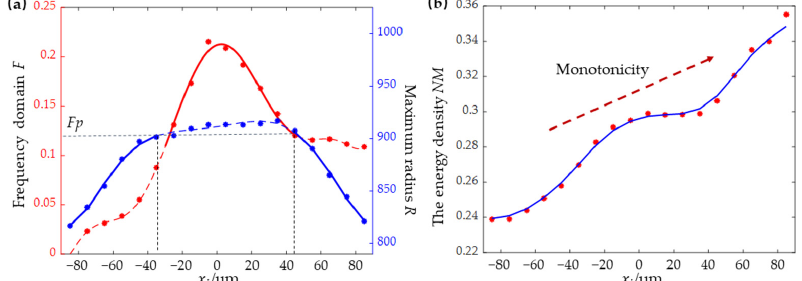
Figure 4. Three different evaluation function were sampled from an experiment regarding defocus positions (curves represent a polynomial fit): ( a ) the frequency domain method using normalized DFT and the maximum radius method (the dashed lines corresponding to high sensitivity is used as the criteria for defocus determination); ( b ) the energy density method. To sum up, a high-sensitivity determination algorithm combined using the above three defocus evaluation indicators is proposed. The working process of the proposed al- gorithm is as follows. Firstly, the frequency domain evaluation values F , maximum radii R , and energy density NM are calculated from a BFP image. Since the F – 𝑥 (cid:3036) curve is di- vided into a high-sensitivity part and a less-sensitive part by the threshold value Fp . When F is less than Fp , the maximum radius method is used to calculate the defocus position based on the R max – 𝑥 𝑖 curve; otherwise, the frequency domain method is adopted. Two solutions exist: 𝑥 (cid:2869) and 𝑥 (cid:2870) . The nonmonotonicity is then determined by comparing NM 1 and NM 2 . The algorithm flow chart is shown in Figure 5. The threshold Fp used to deter- mine the defocus position calculation can be determined according to the position where the gradient of the frequency standard curve drops sharply, as shown in Figure 4a. Deter- mining the position 𝑥 (cid:3036) of the defocus BFP image according to the above process provides a key link for the defocus BPF image compensation and a basis for subsequent defocus measurement. Figure 5. Flow chart of the proposed defocus position determination algorithm. A complete BFP image undistortion and ellipsometric error compensation example is shown in Figure 6a using the proposed method. Firstly, the original biased ellipsometric parameters corresponding to each pixel radius were calculated, as shown in Figure 6b, using Equations (3)–(4). Then, based on a calculated defocus position, the incident angle calibration coefficient 𝑓 ’ and the ellipsometric compensation amounts 𝑡𝑎𝑛 (cid:2870) 𝛿 (cid:2959) and 2𝛿 (cid:2940) were determined from the previous calibration results, using which the R – 𝜃 correction and ellipsometric parameter compensation were completed, as shown in Figure 6c. Fi- nally, the film thickness was further calculated using LM fitting.